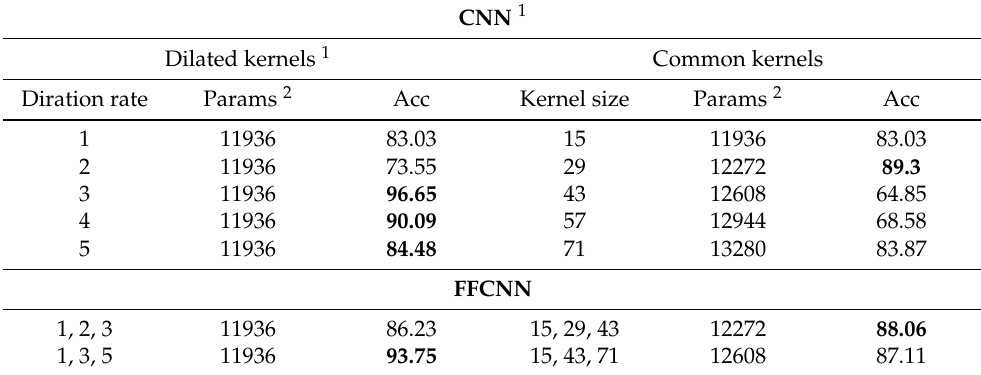
Table 6. Results of dilated convolution and common convolution.